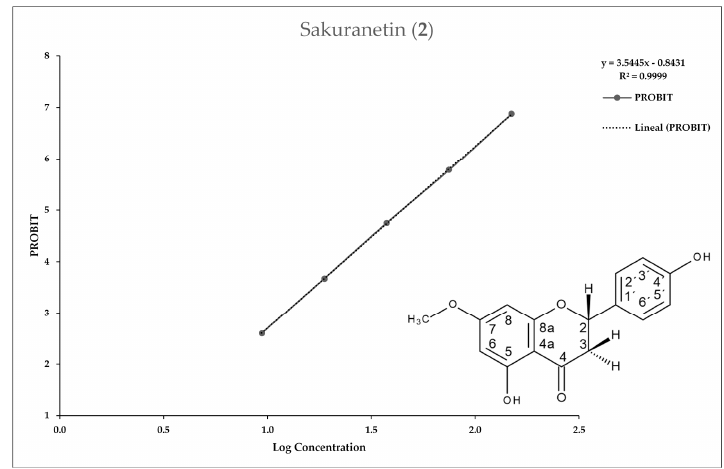
Figure 3. Antiprotozoal activity of Sakuranetin 2 against Entamoeba histolytica. Growth inhibition of 97.24% at 150 µg/mL, IC 50 = 44.51 µg/mL.